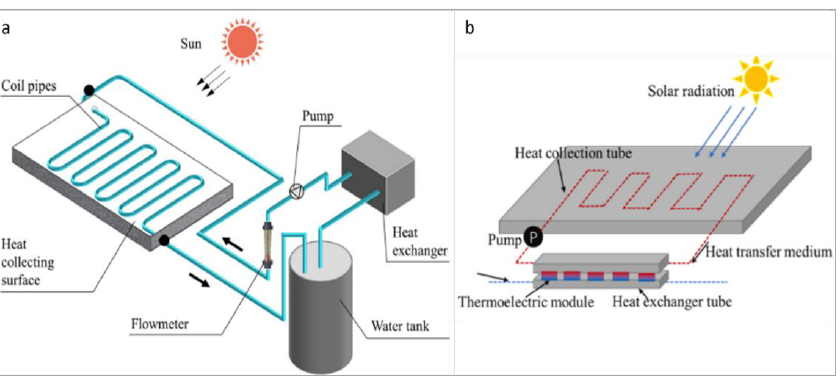
Figure 10. This 3D view illustrates the path solar collector system connected to ( a ) heat exchanger and ( b ) TEG modules [79, 80, 32].